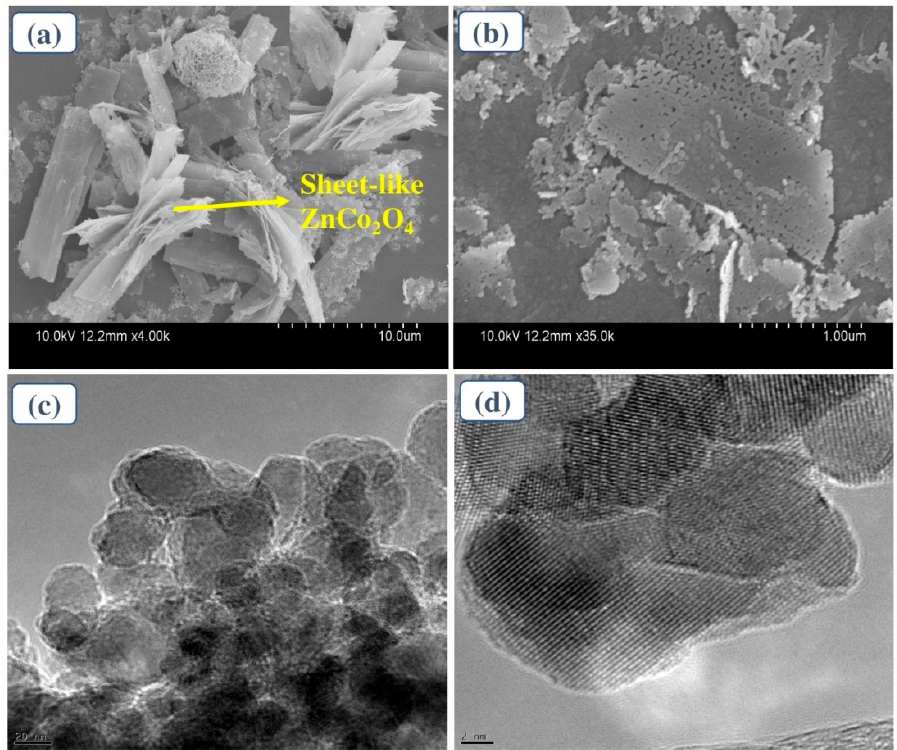
Figure 2. Scanning electron microscope (SEM) ( a , b ) and HR-TEM ( c , d ) images of sheet-like ZnCo 2 O 4 (inset clearly shows the sheet-like structures).